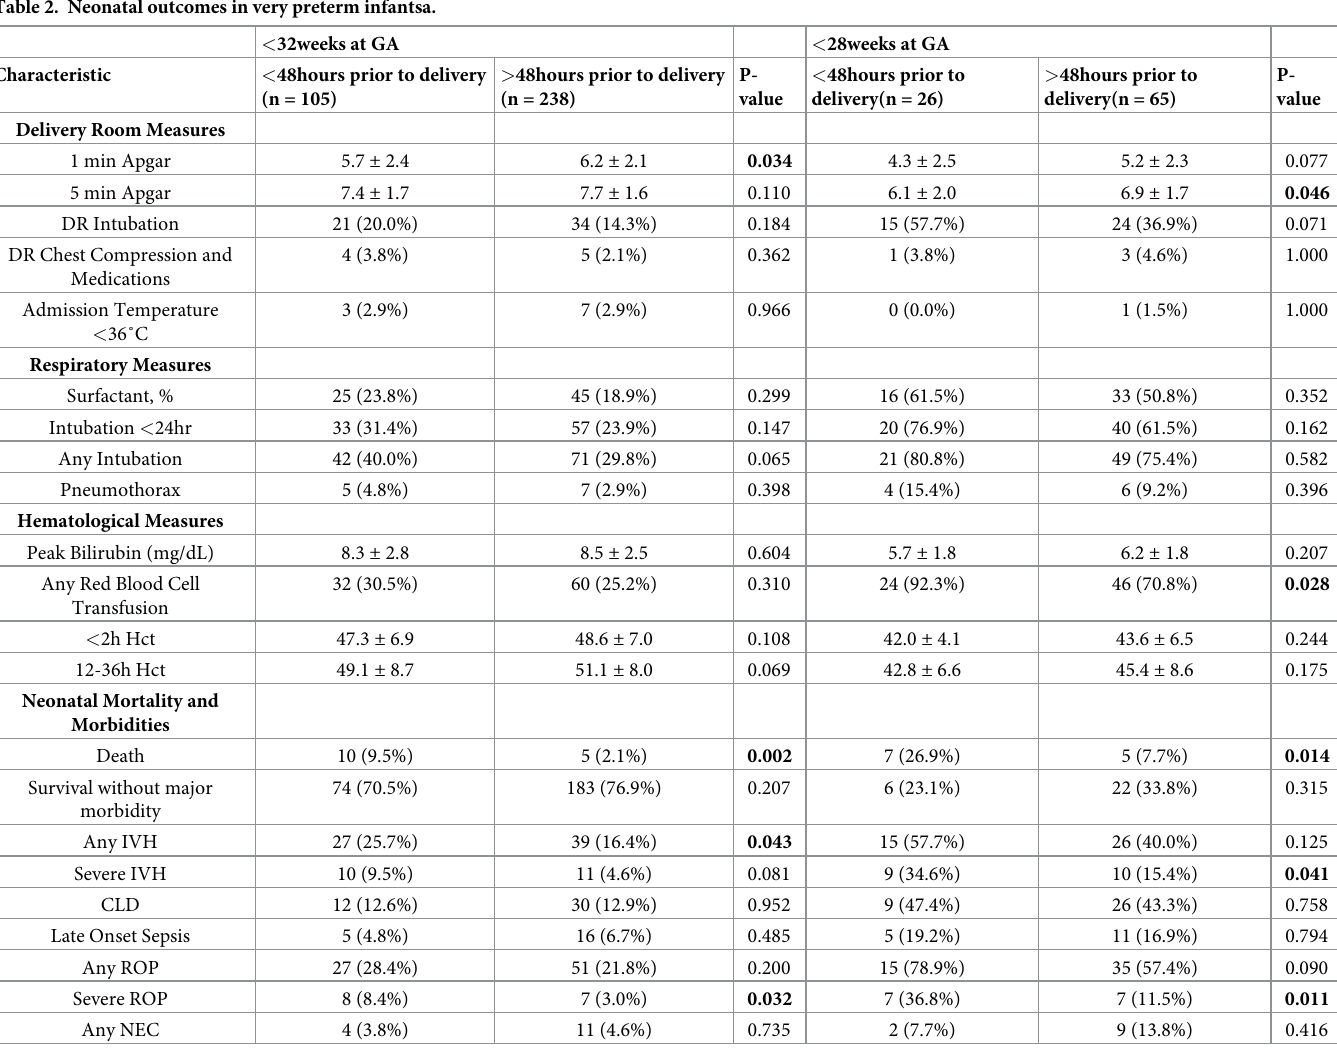
Table 2. Neonatal outcomes in very preterm